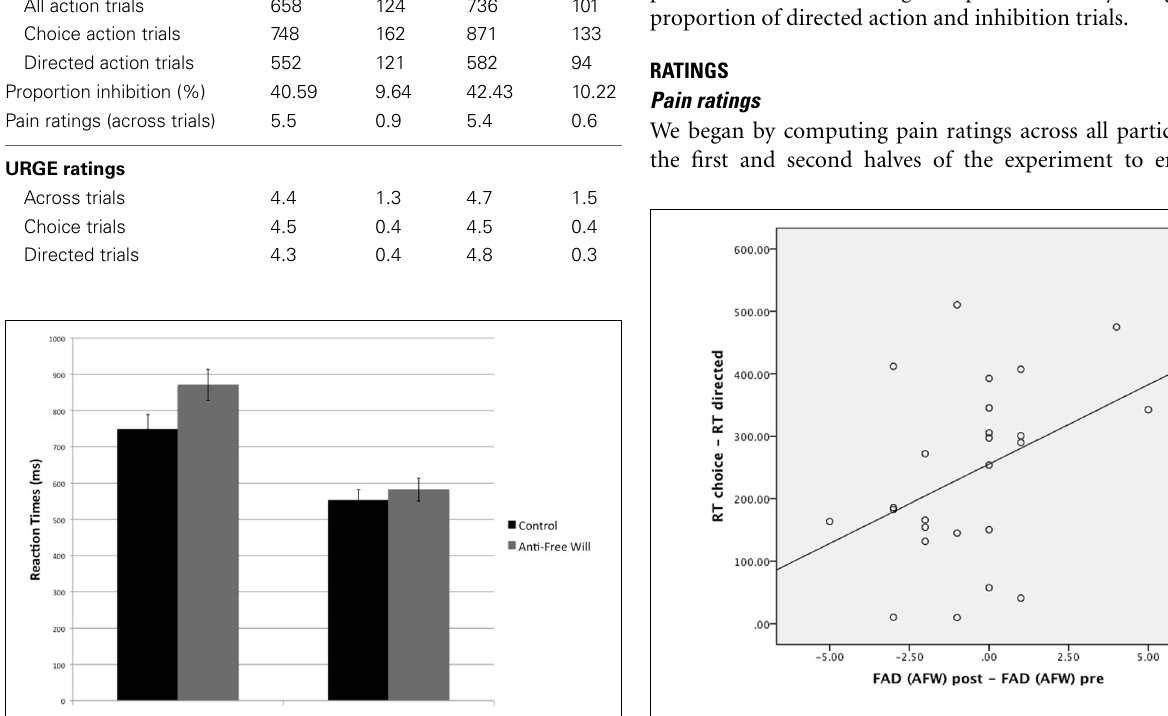
FIGURE 4 | Correlation of difference scores (post-test minus pre-test) on the anti-free will subscale of the FAD-Plus with the decision response time index (mean response times on choice minus directed